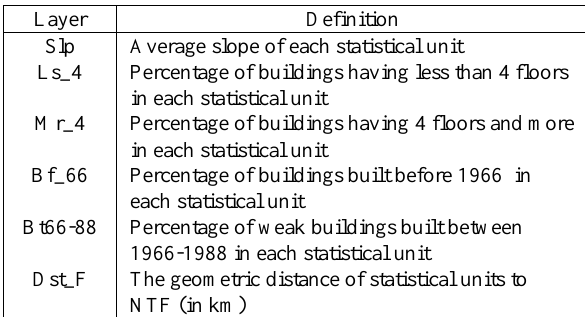
Table 2. Contributing criteria and their definitions